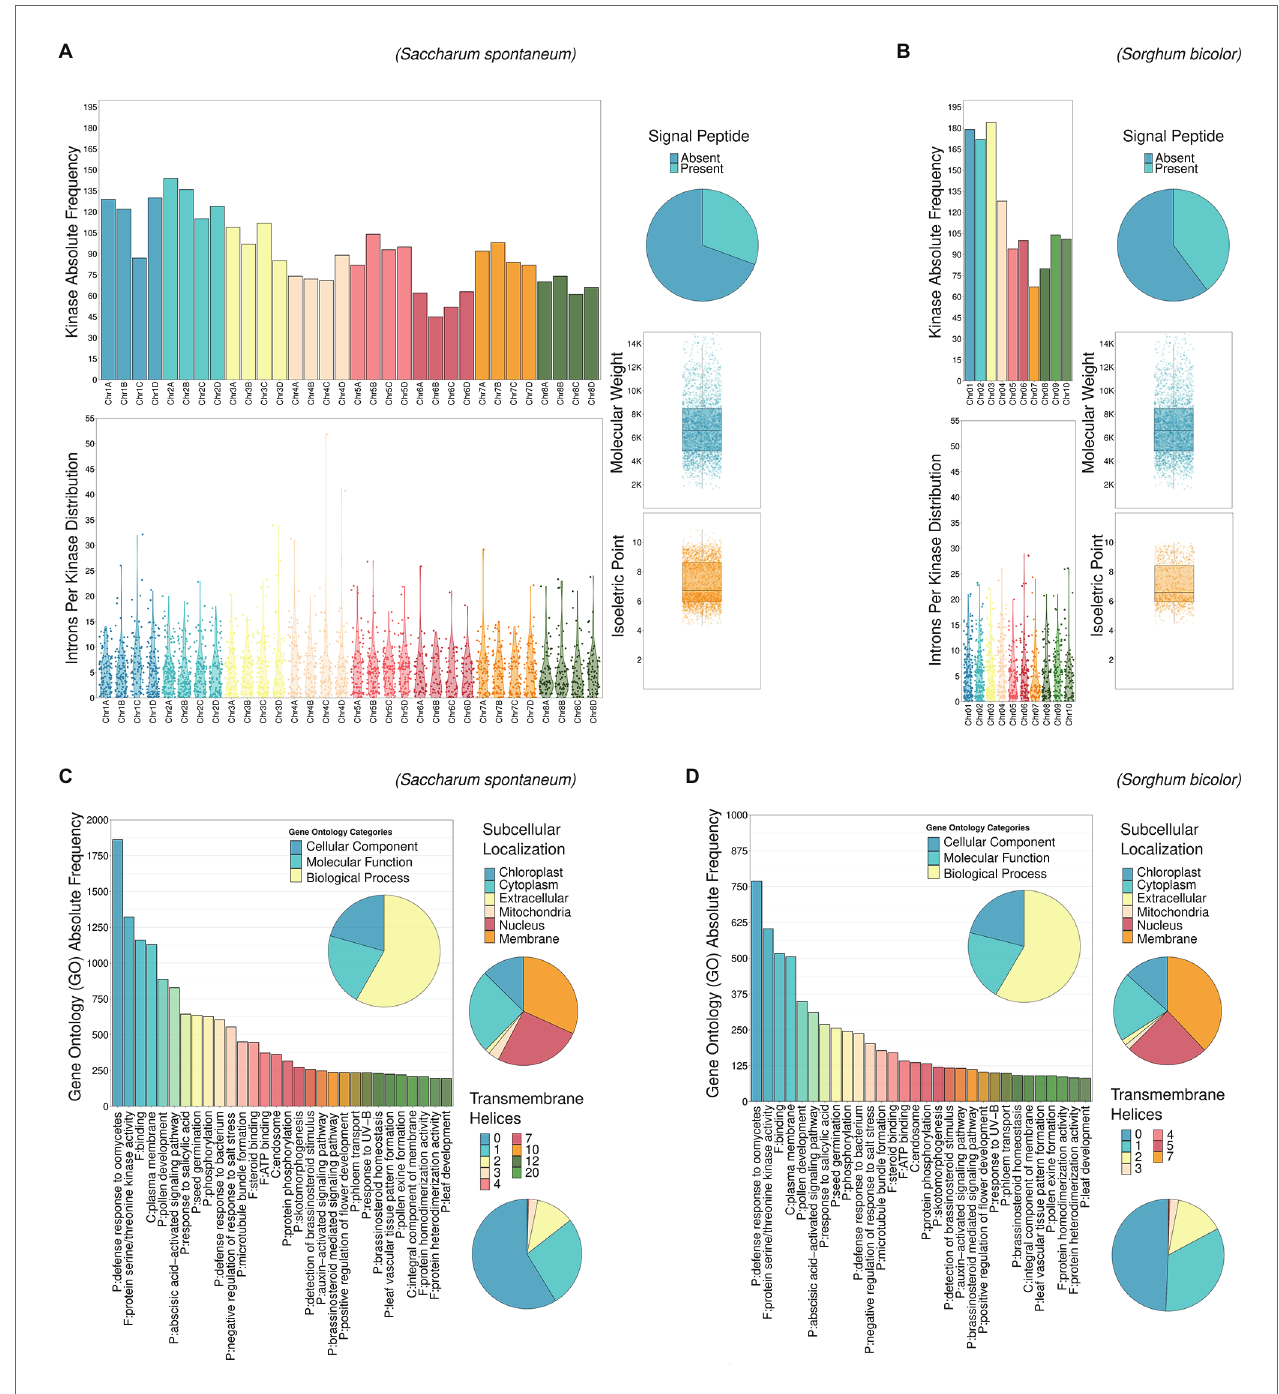
FIGURE 2 | Descriptive analysis of kinase characteristics in Ssp (A,C) and Sbi (B,D) : chromosomal distribution, intron length and chromosomal occurrence, presence of signal peptides, molecular weights (MWs), isoelectric points (pIs), Gene Ontology (GO) terms, subcellular localization, and presence of transmembrane